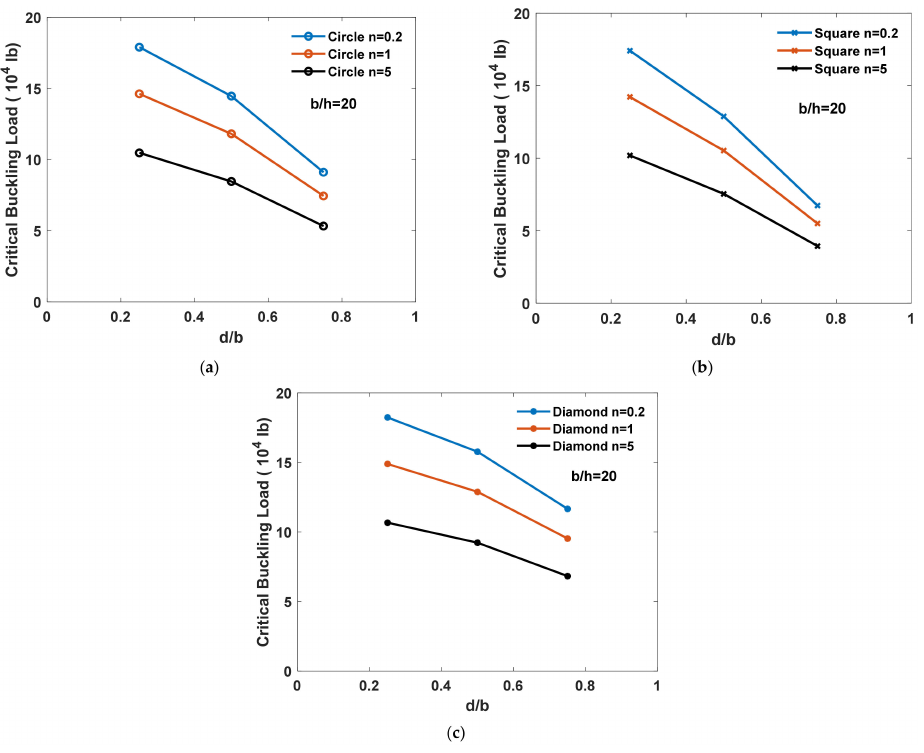
Figure 13. The variation of the opening aspect ratio on the critical buckling load for ( a ) circle, Buildings 2022 , 12 , 802 ( b ) square, and ( c ) diamond openings for an aspect ratio b/h = 20.